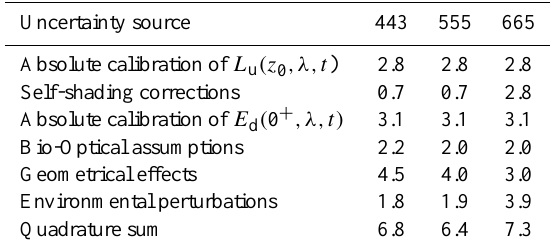
Table 5. Uncertainty budget (in percent) for R rs determined from TACCS-P